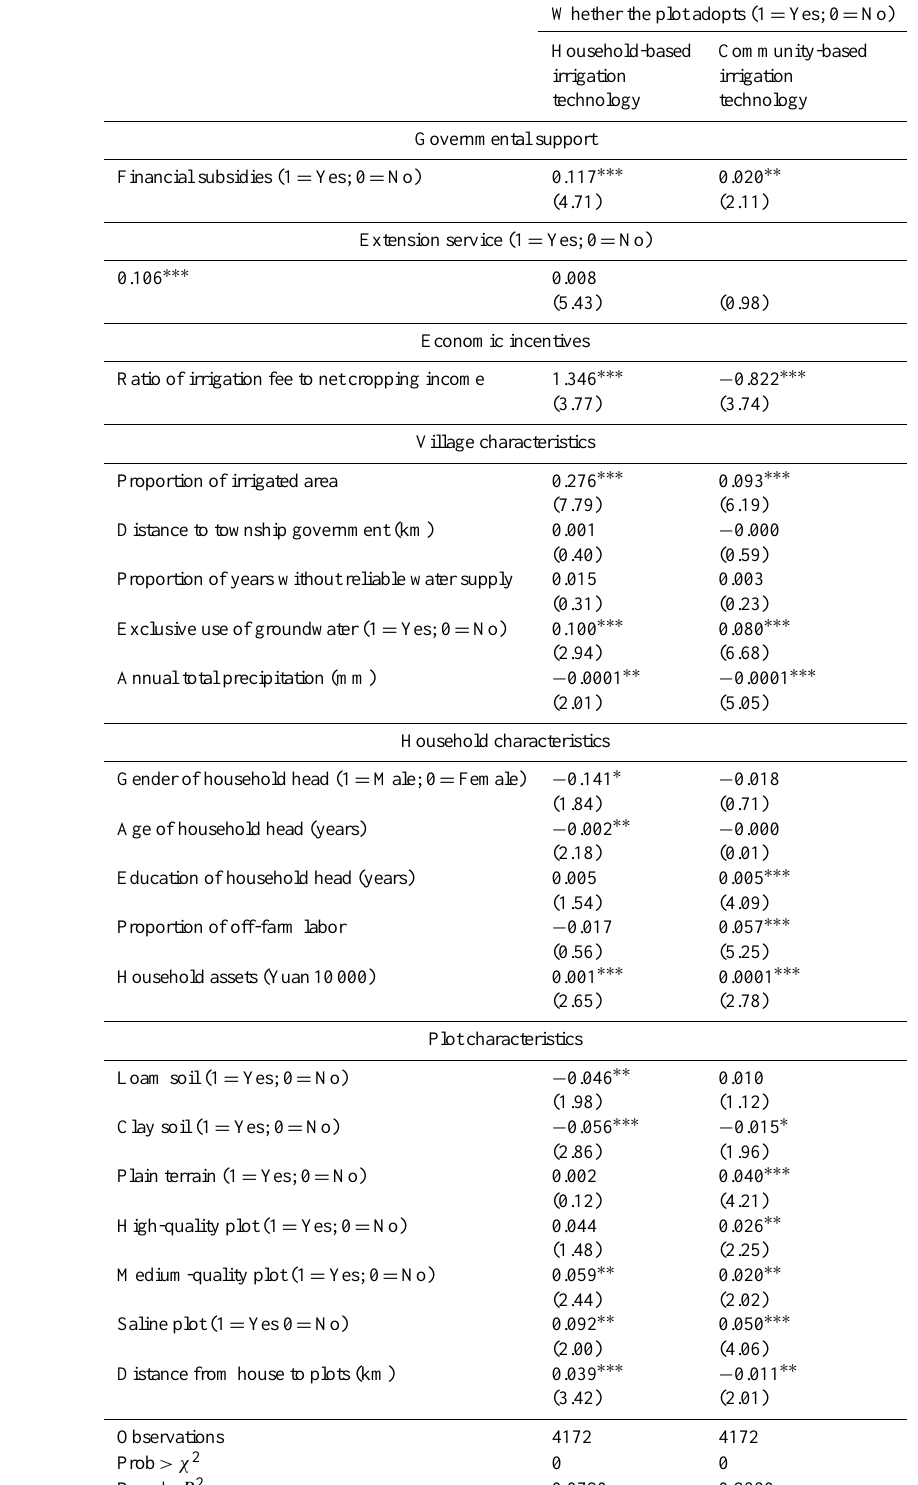
Table 5. Estimates of determinants of the adoption decision of modern irrigation technology in China (Logit model).